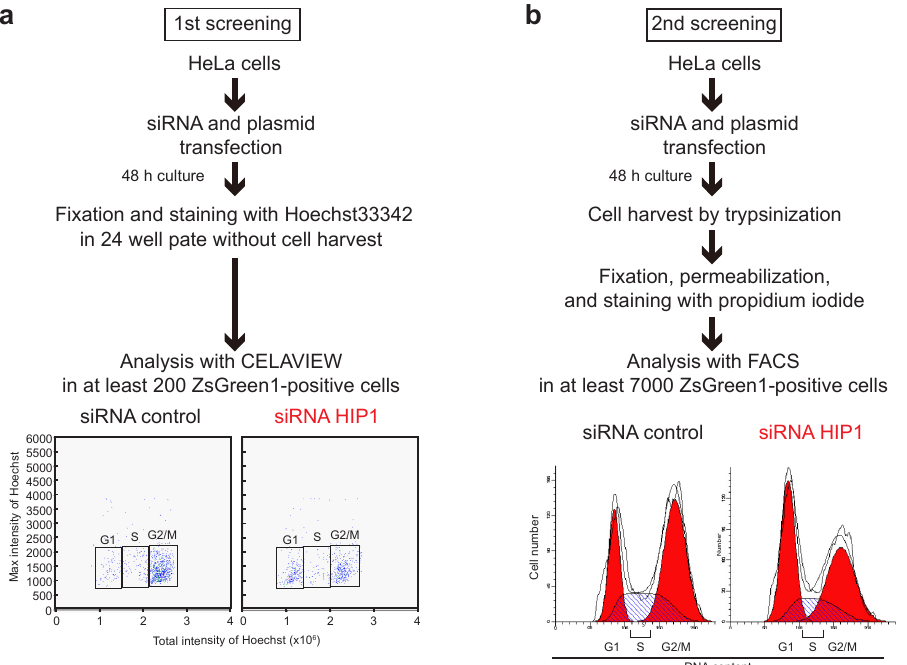
Figure 1. Summary of siRNA screening for candidate suppressors of Vpr-induced G2 arrest. ( a ) For the initial screening, HeLa cells were co-transfected with pME/F-Vpr-IRES-ZsGreen1 and 100 nM individual siRNAs from the siRNA mini-library or control siRNA. At 48-h post-transfection, cells were fixed and stained with 5 µ g/mL Hoechst33342 to measure DNA content in at least 200 ZsGreen1+ cells using CELAVIEW RS100. ( b ) For secondary screening, HeLa cells were co-transfected with pME/F-Vpr-IRES-ZsGreen1 and control siRNA or 100 nM of individual siRNAs that inhibited Vpr-induced G2 arrest according to the initial screen. At 48-h post-transfection, cells were harvested by trypsinization, fixed, permeabilized, treated with RNase A, and stained with 50 µ g/mL propidium iodide to measure DNA content in at least 7000 ZsGreen1+ cells by flow cytometry. The traces on the cell cycle histograms are written by the ModFit LT software automatically.